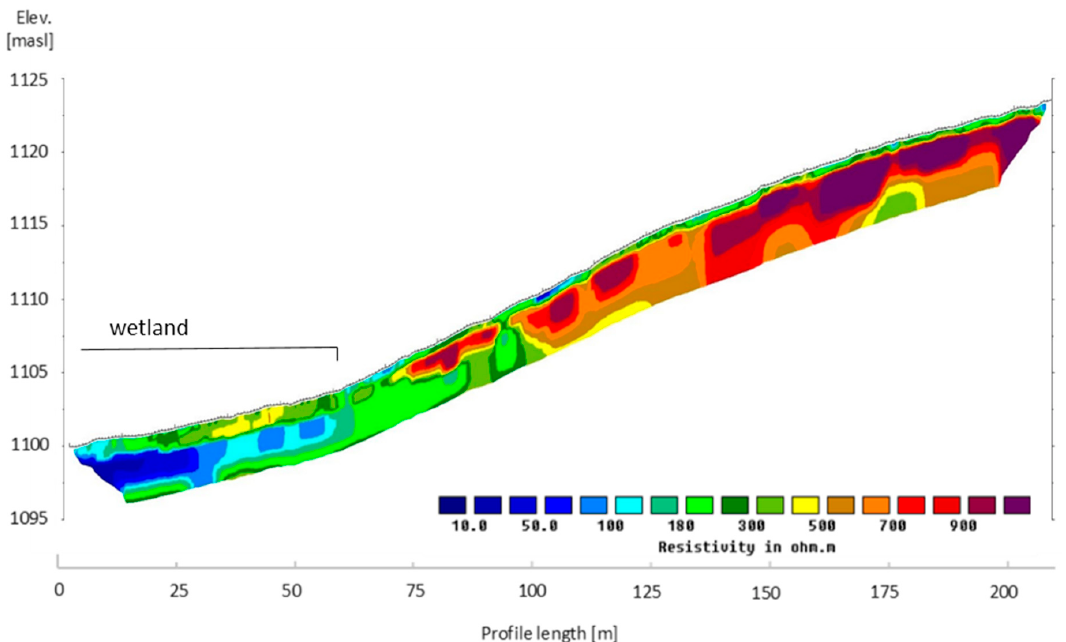
Figure 9. Electrical resistivity tomography with topography (unit electrode spacing 0.7 m) of a transect stretching from the wetland fringe to the mid-slope position at the plot under crop production.